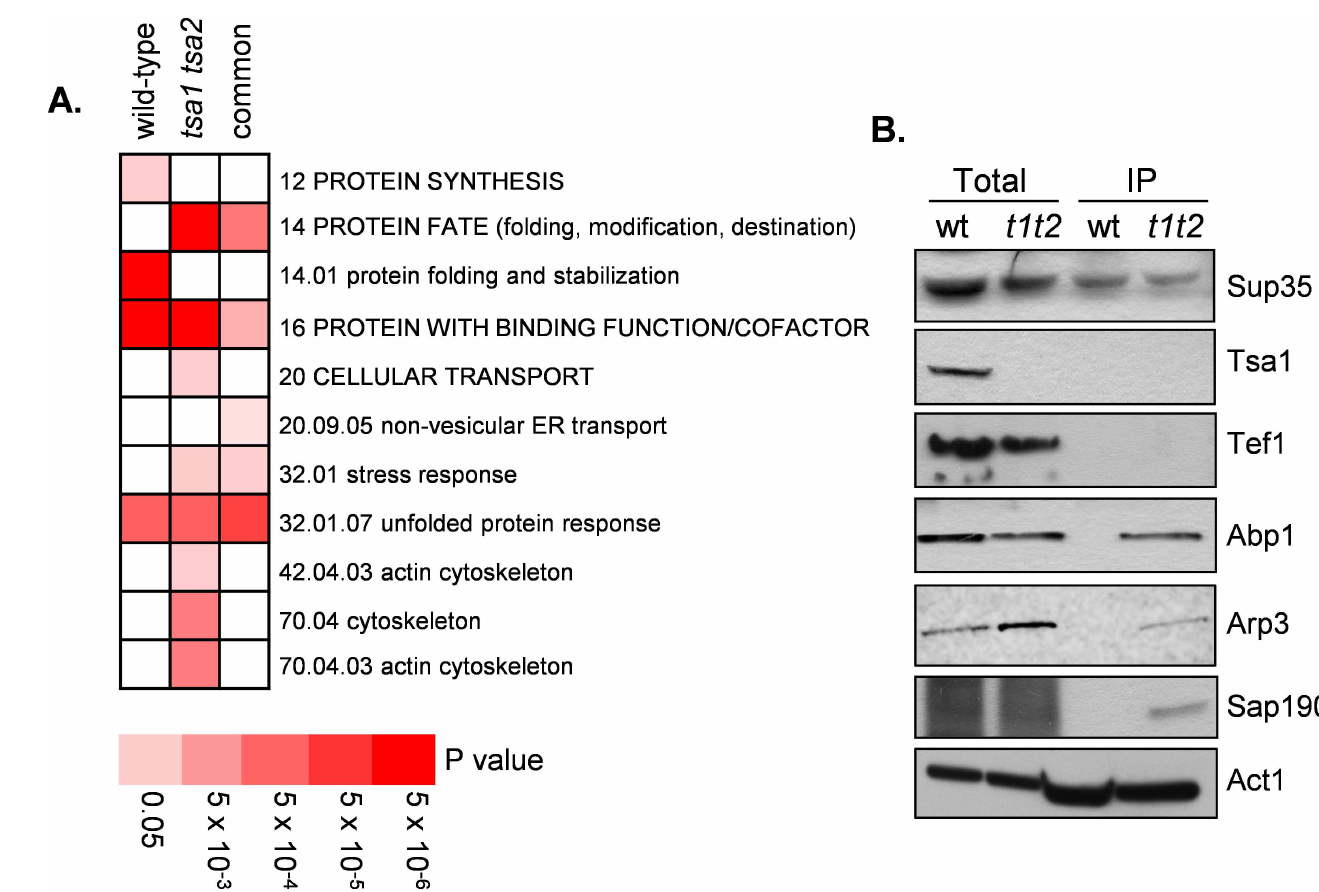
Fig 1. Identification of Sup35-interactingproteinsin wild-type and tsa1tsa2 mutantstrains.A. FunctionalcategorisationofSup35-associated proteins.ResultsareorderedonMIPScategoryclassificationnumbersandoverarchingcategoriesareincapitals.Whereanoverarchingcategorywas enriched,sub-categorieswithintheoverarchingcategorywereomittedfromthegraph.Confidence ofeachclassificationcategoryisshownasBonferroni corrected p -values. B. Sup35-TAP wasimmunoprecipitatedfromthewild-typeand tsa1tsa2 mutantandpossibleinteractions examinedusingimmuno-blot analysiswiththeindicatedantibodies. Sup35-TAP co-immunoprecipitatesAbp1,Arp3andSap190ina tsa1tsa2 mutant. Sup35-TAPco-immunoprecipitates Act1inbothwild-typeand tsa1tsa2 mutantstrains.TotaldenoteswholecellextractsandIP denotesimmunoprecipitates.